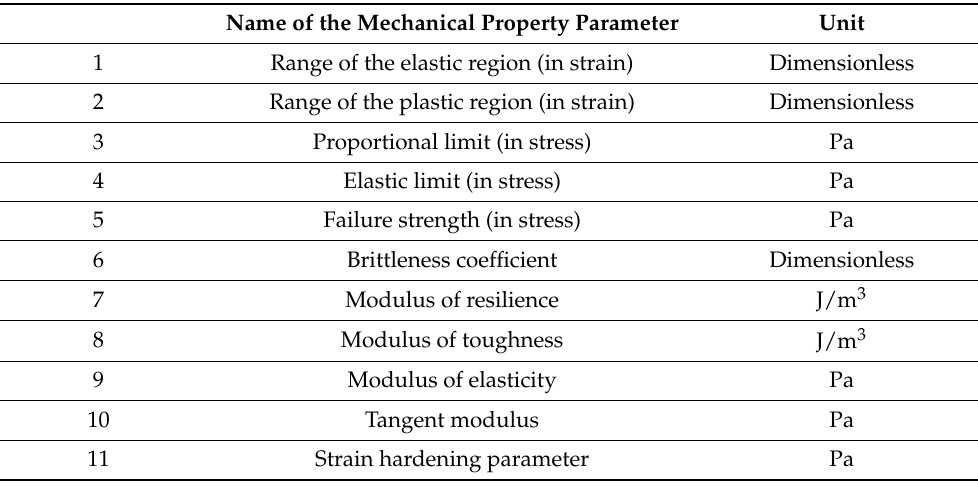
Table 1. Mechanical properties of compact bone that can be defined and extracted from the stress– strain